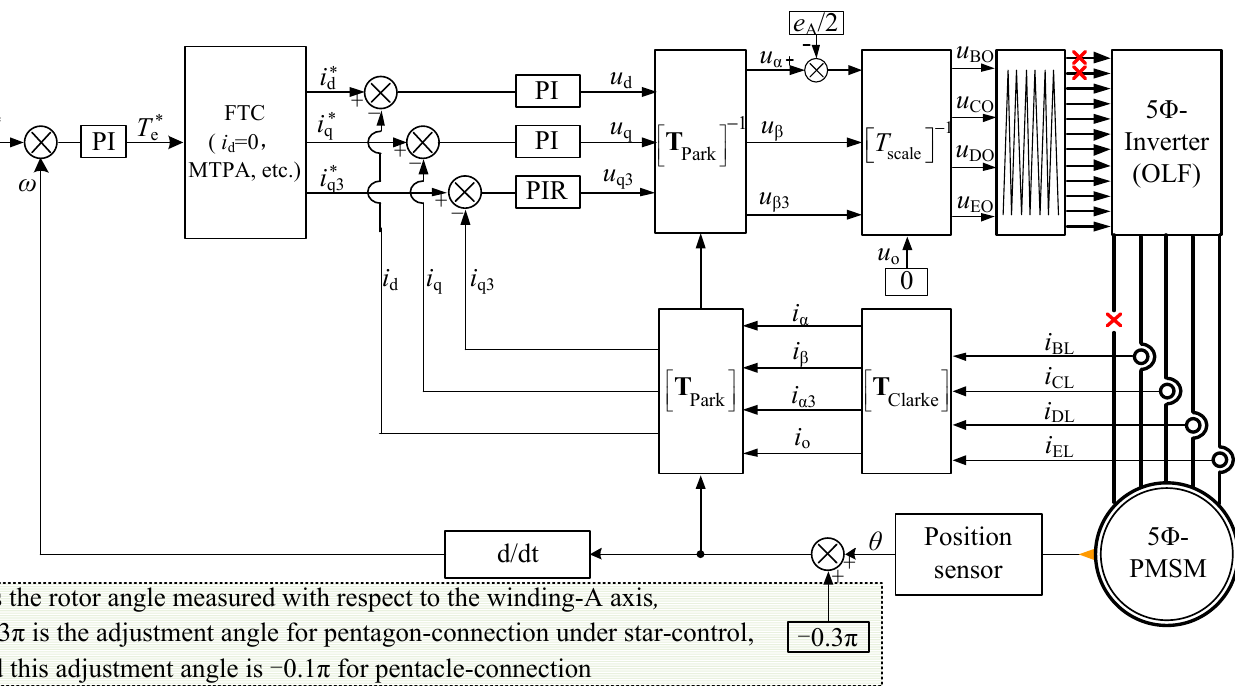
Figure 3. Graphical illustration for a single-phase open fault. For a star-connection mode, the open-line fault and open-phase fault create the same effect since the phase and line are the same. Thus, their fault-tolerant decoupling controls are the same, and hereby termed “star-control”. Readers may refer to Figure 4 for an overview of the star-control under a single-line open fault, where the adopted Clarke transformation is no longer a unitary matrix to offer unbalanced voltages even with a balanced u d and u q . Notice that superscript * indicates the reference value.